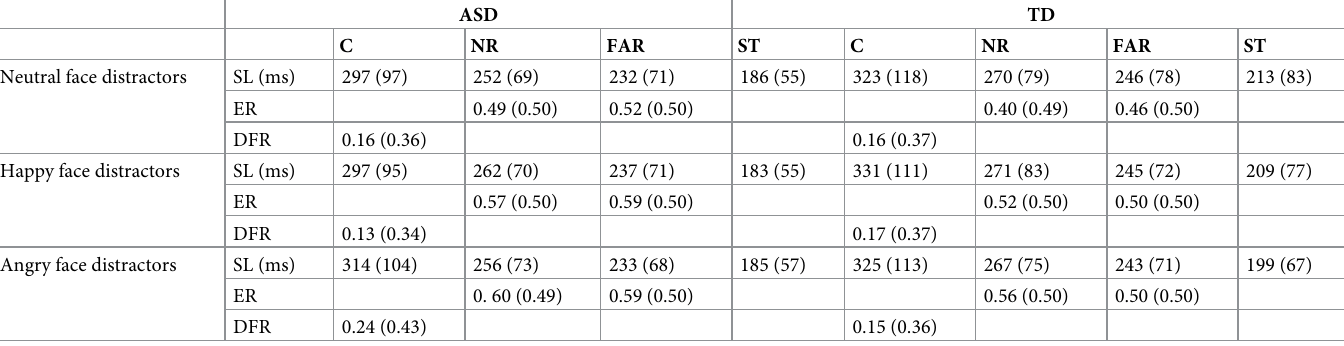
Table 2. Means and standard deviations of eye movement measures recorded for neutral, happy and angry face distractors in central (C), parafoveal (NR), periph- eral (FAR) and single target (ST) conditions in both groups. ASD